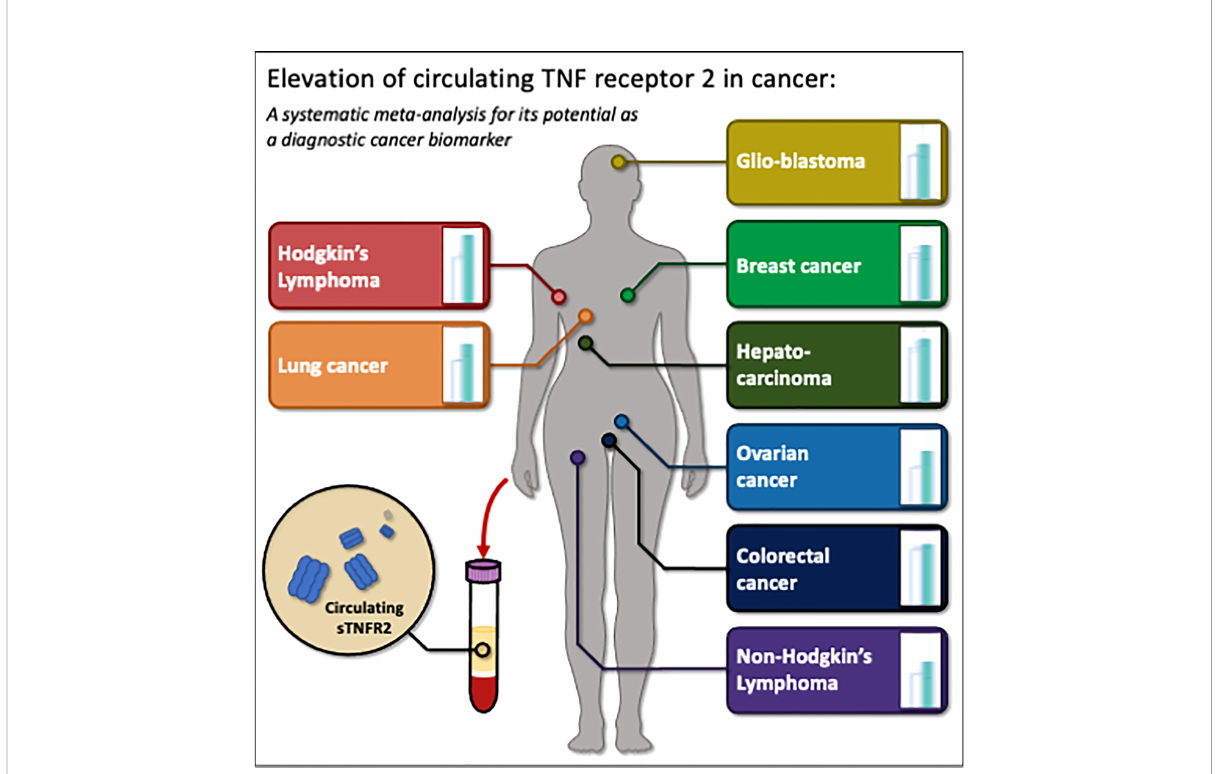
FIGURE 5 The summary schema of the elevated sTNFR2 levels in various cancers, and its potential as a biomarker for cancer detection. Figure was created using Microsoft power